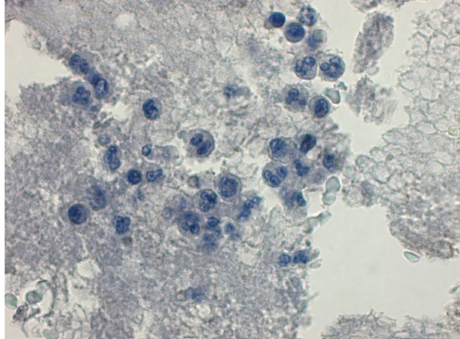
Figure 3. Control group, negative Bax expression was observed in lymphocytes, monocytes and neutrophils. Negative immunochemistry staining, bar 50